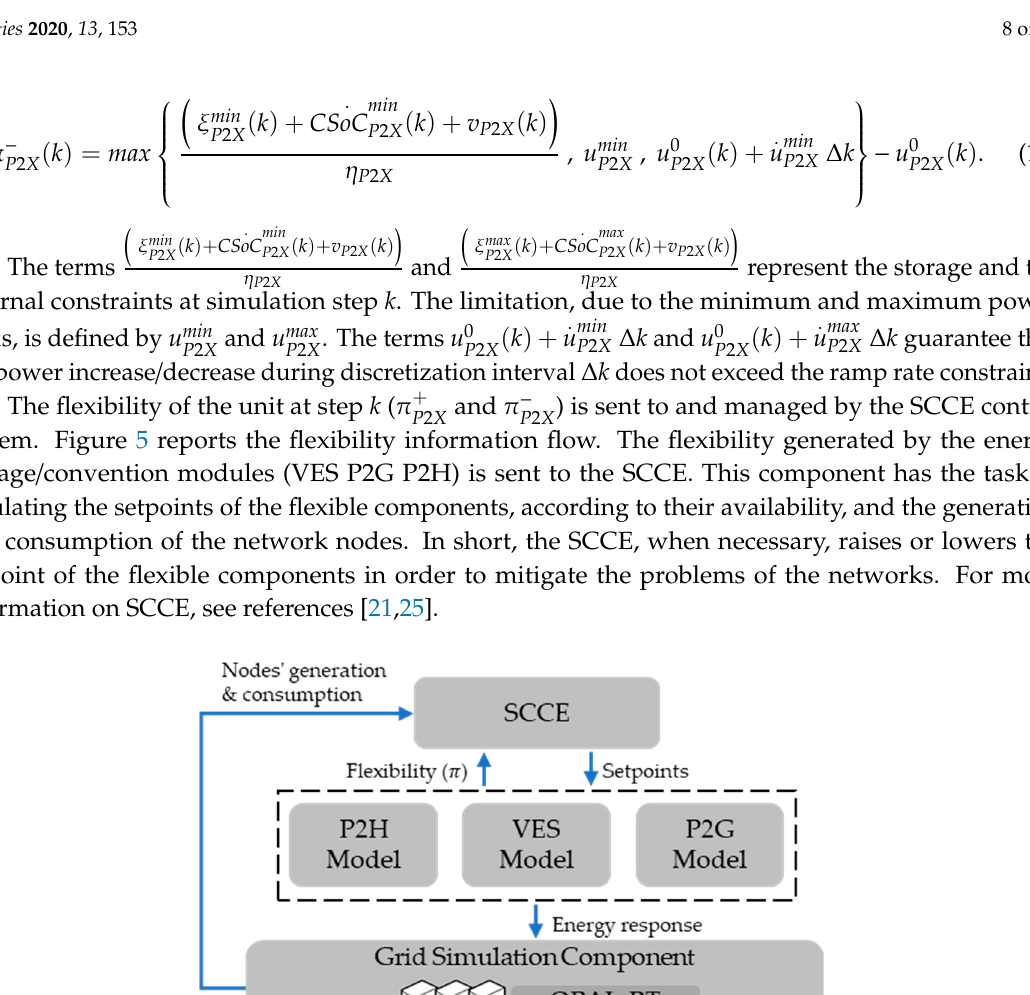
Table 1. Technologies connected to the electric grid.